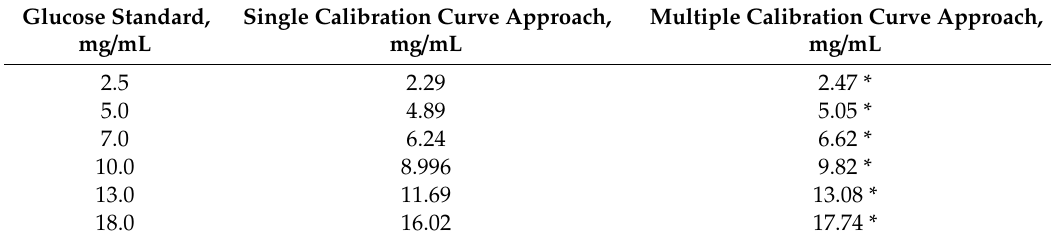
Table 1. The impact of standard calculation methodology on fermentable reducing sugar yields in practical